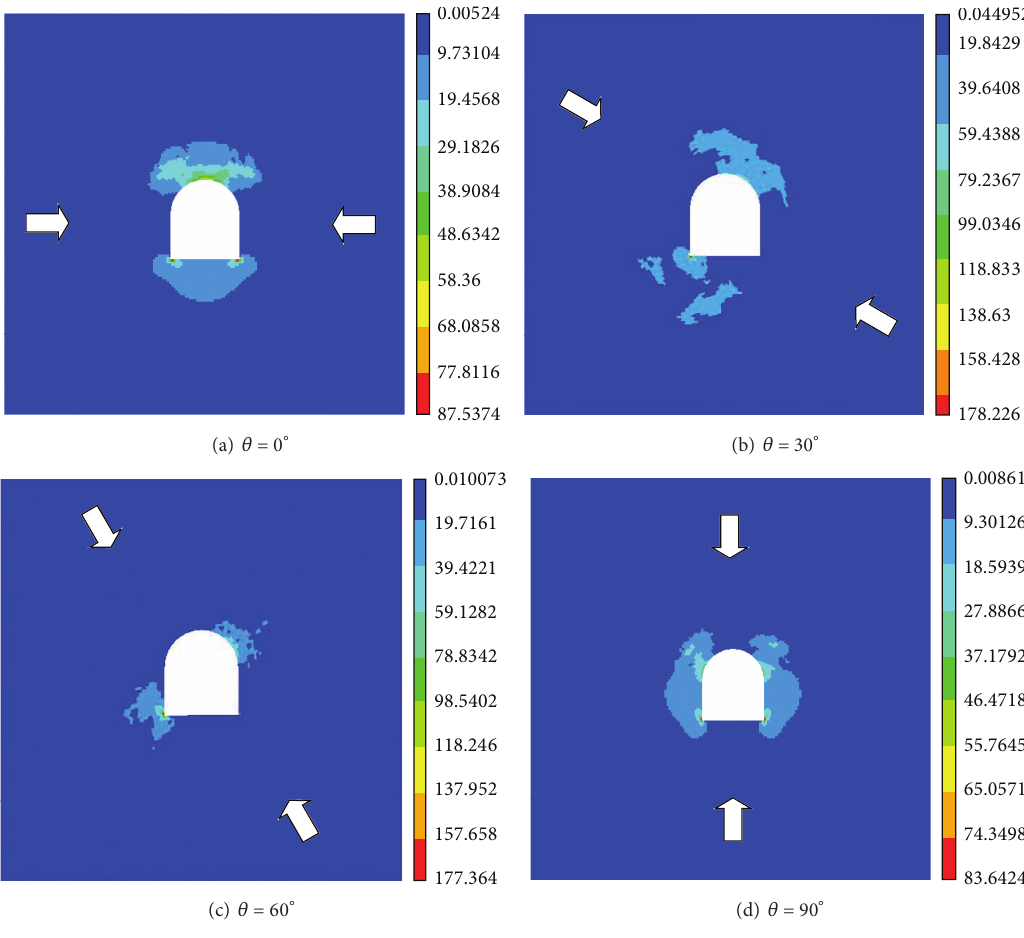
Figure 6: SED distributions under four different orientation angles of the maximum principal stress with the floor face (unit: kJ/m 3 ).